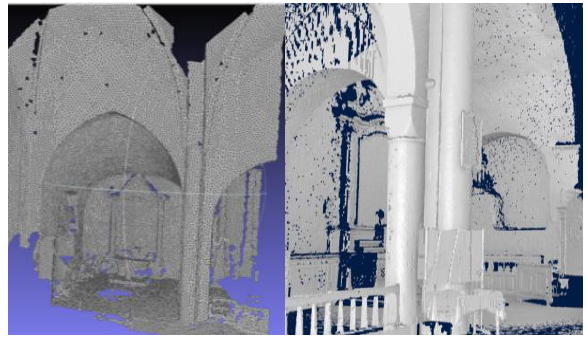
Figure 10. Two views of the realised mesh by using MeshLab